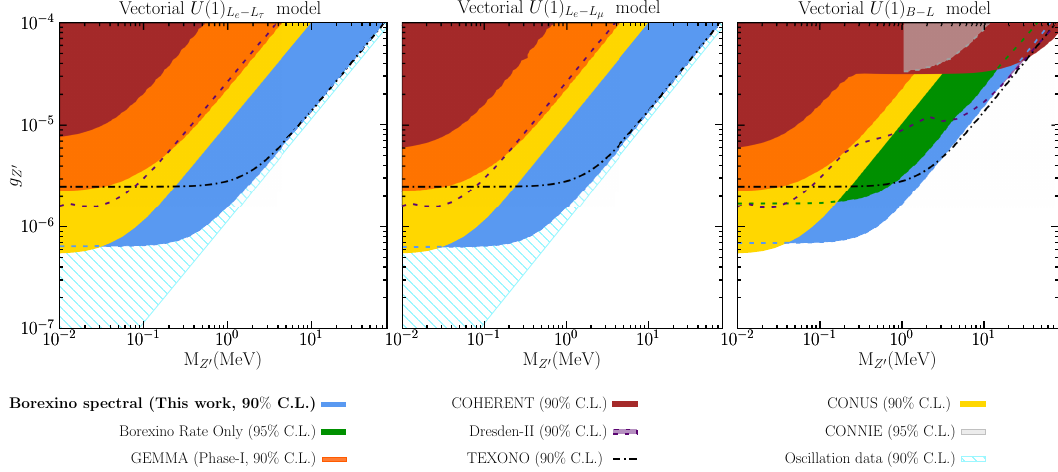
Figure 5 . Bounds from our analysis of Borexino Phase II spectral data (at 90% CL for 1 d.o.f., using two-sided intervals, i.e., ∆ χ 2 = 2 . 71 ) on the vector mediators associated to a new U(1) 0 symmetry, as indicated in the top label for each panel. Our results are compared to our derived bounds from GEMMA [45, 50], TEXONO [50, 51], COHERENT [15, 16, 52], and Dresden-II reactor experiment [14, 15], as well as those derived from a global fit to oscillation data [50], all of them obtained with the same statistical criterion. We also show the bounds from CONNIE [13] (95% CL) and CONUS [54] (90% CL) which we have obtained applying an overall rescaling factor to their published bounds on a universally coupled vector (see text for details). For the B − L model, the line labelled “Borexino Rate Only” shows the approximate bound derived (at 95% CL, 1 d.o.f., for one-sided intervals) in ref. [26] (see also ref.